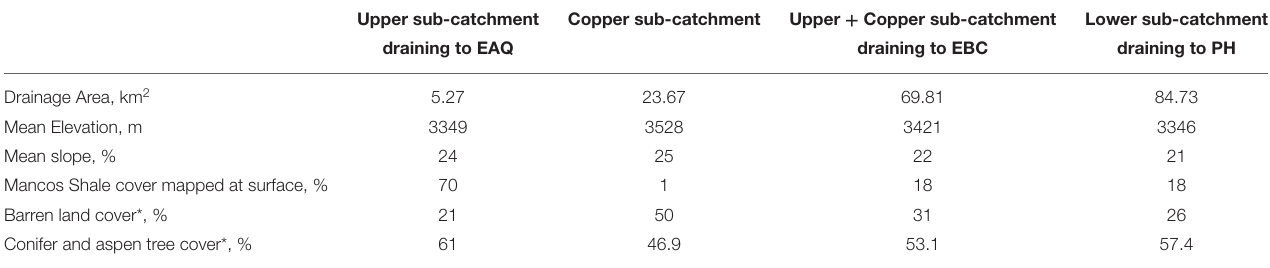
TABLE 2 | Characteristics of sub-catchments in the East River Watershed relevant to this study (modified from Carroll et al.,